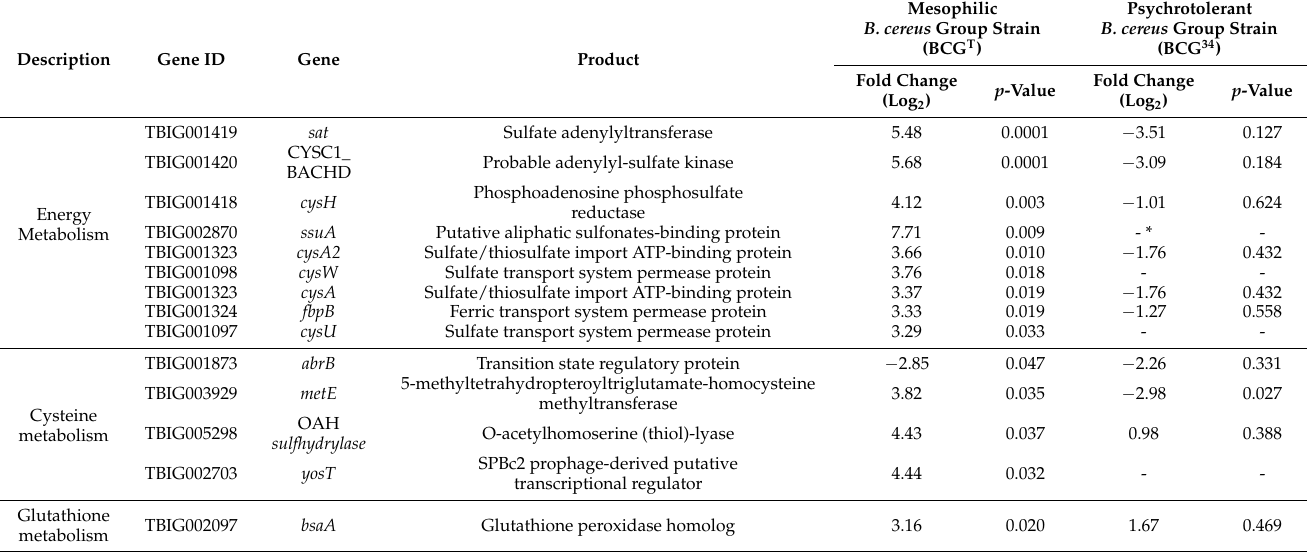
Table 4. Differential gene expression related to energy metabolism of mesophilic B. cereus group strain (BCG T ) and psychrotolerant B. cereus group strain (BCG 34 ) grown at 10 ◦ C compared to growth at 30 ◦